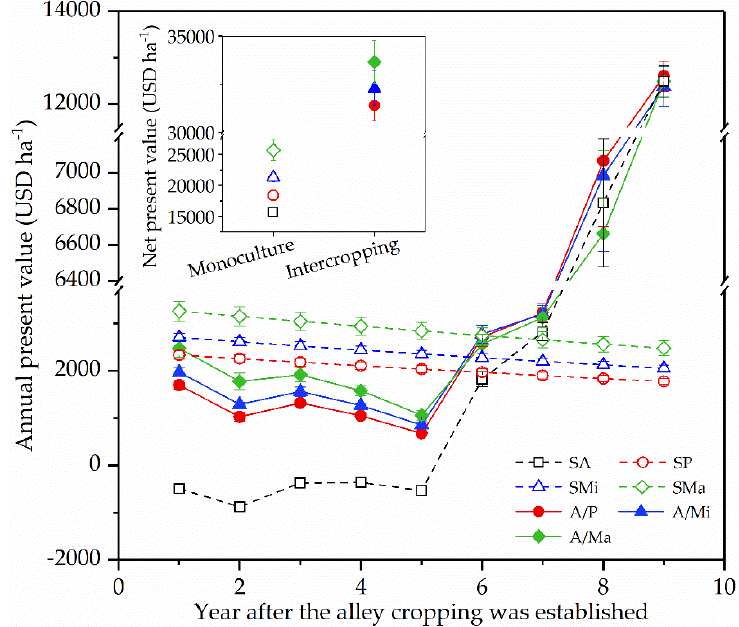
Figure 3. Annual present value and net present value of different cropping systems during the alley cropping period in Exp.2. The economic profitability in each year during the alley cropping period was showed by the present value, not the actual revenue without discount in each year. Each symbol represents mean ± SE ( n = 3). SA, SP, SMi and SMa present sole apple, sole peanut, sole millet and sole maize, respectively. A/P, A/Mi and A/Ma mean apple/peanut systems, apple/millet systems and apple/maize systems, respectively. The data were settled in US Dollar (USD), 1 Dollar = 6.12 Chinese Yuan (CNY) (31 December 2014).